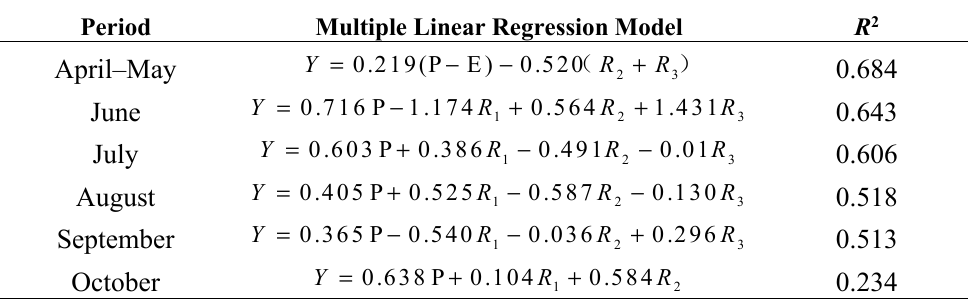
Table 3. Regression analysis results from April to October.